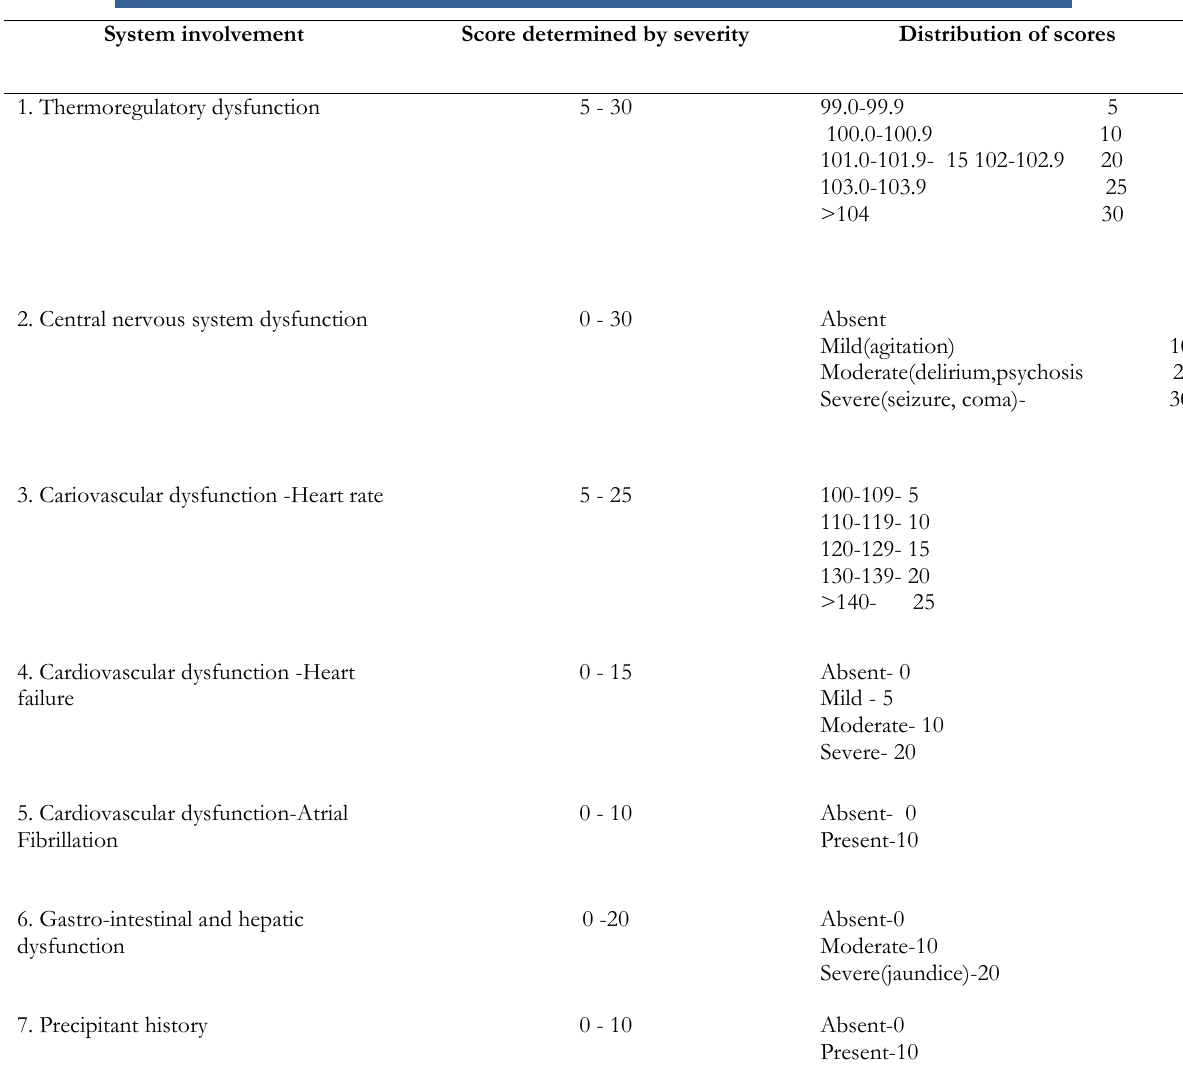
Table 5.1. Burch–Wartofsky Point Scale for diagnosis of thyrotoxic